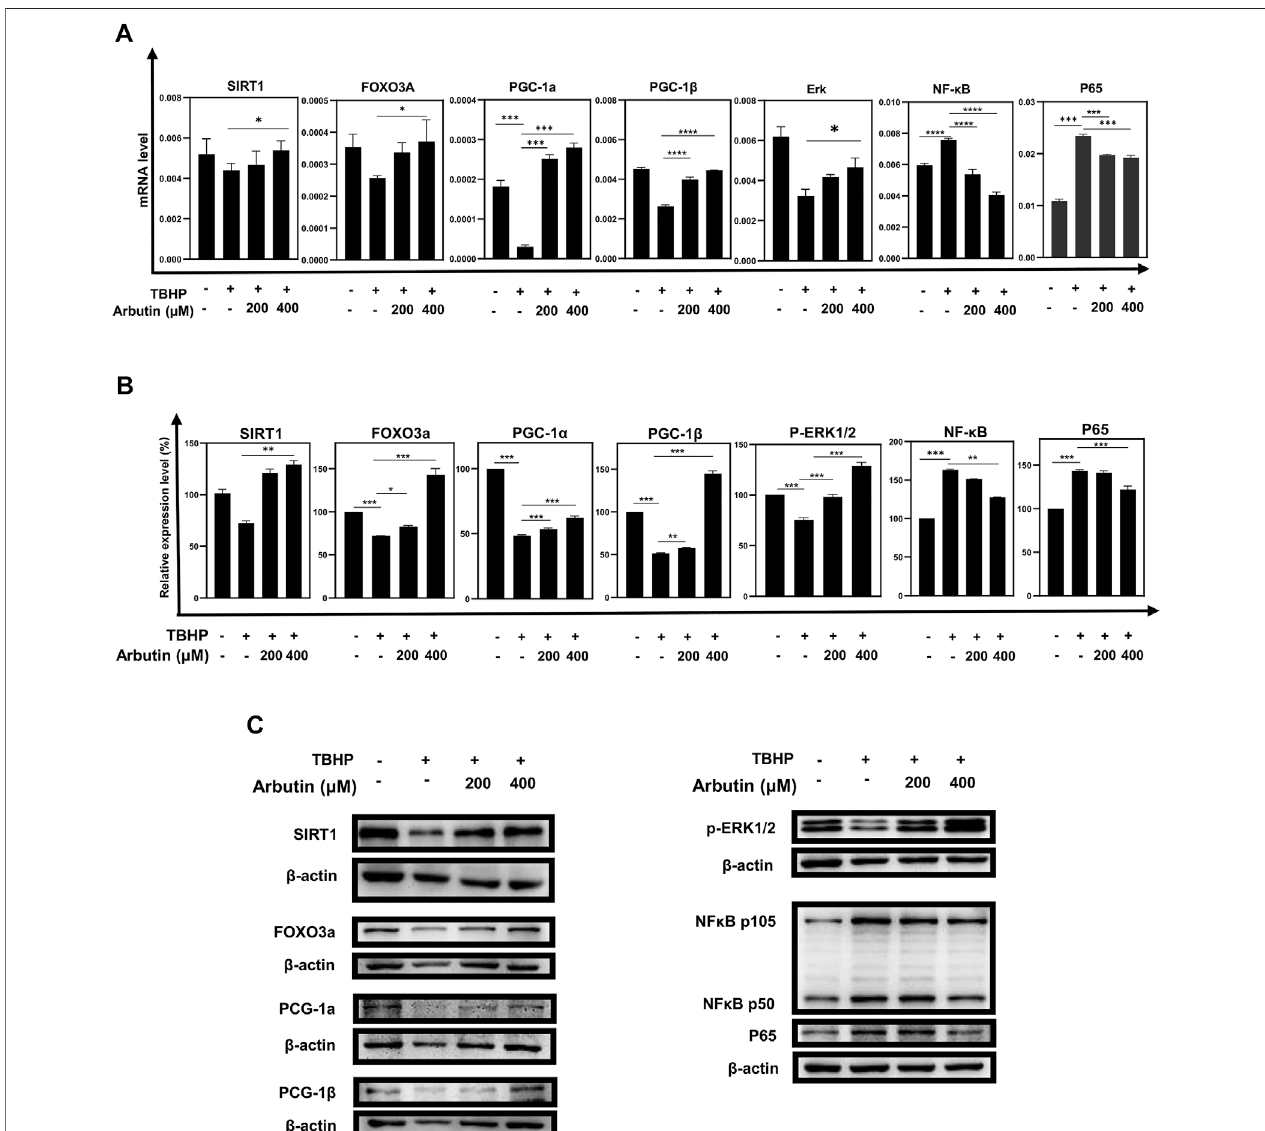
FIGURE4| Arbutinexertedprotectiveeffects via theSIRT1/FOXO3A/PGC-1 α / β and NF- κ B/p65signaling pathway. (A) qRT-PCRwasused tomeasure transcript levels of the SIRT1/FOXO3a/PGC-1 α / β pathway and NF- κ B/p65 genes. TBHP decreased the expression of SIRT1, FOXO3a, and PGC-1 α / β and increased the expressionofNF- κ B/p65,whereasmRNAlevelsinthegroupsthatwerepretreatedwithArbutinshowedreversedtrend. (B) westernblotswereconductedtodetectthe proteins level of SIRT1, FOXO3a, PGC-1 α / β , p-ERK, and NFKB1/P65. (C) imageJ was used to analyze the relative expression level of the proteins mentioned above (* p < 0.05, ** p < 0.01, *** p < 0.001, n = 3, bars represent SD).